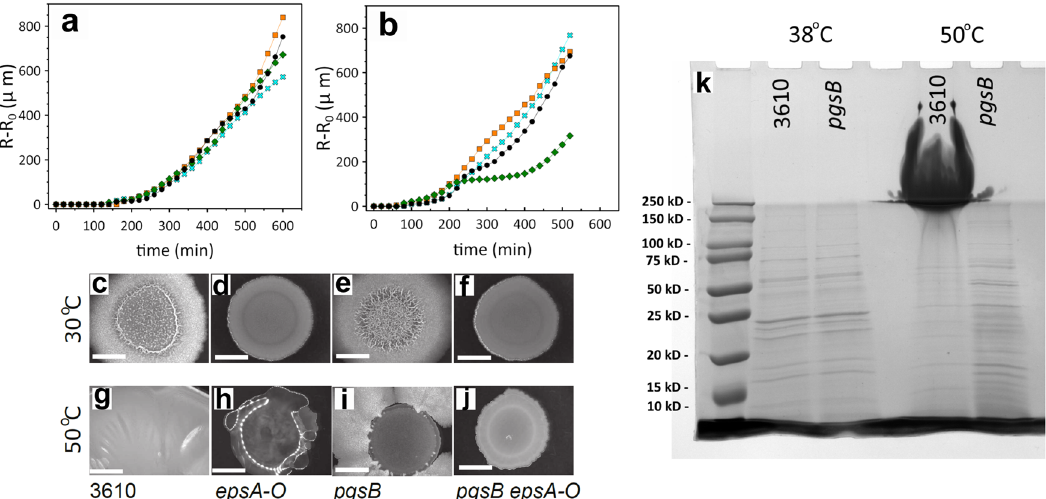
Fig. 5 PGA production is temperature dependent. a Measurements of the edge expansion at 30 ∘ C and b 42 ∘ C for NCIB 3610 (black circle), epsA-O (green diamond), pgsB (orange square), pgsB epsA-O (cyan cross). Colony morphology after 48 h incubation at c – f 30 ∘ C, and g – j 50 ∘ C. Scale bar is 5 mm. k Analysis of PGA abundance by polyacrylamide gel electrophoresis of samples extracted from NCIB 3610 and pgsB after growth at 38 ∘ C and 50 ∘